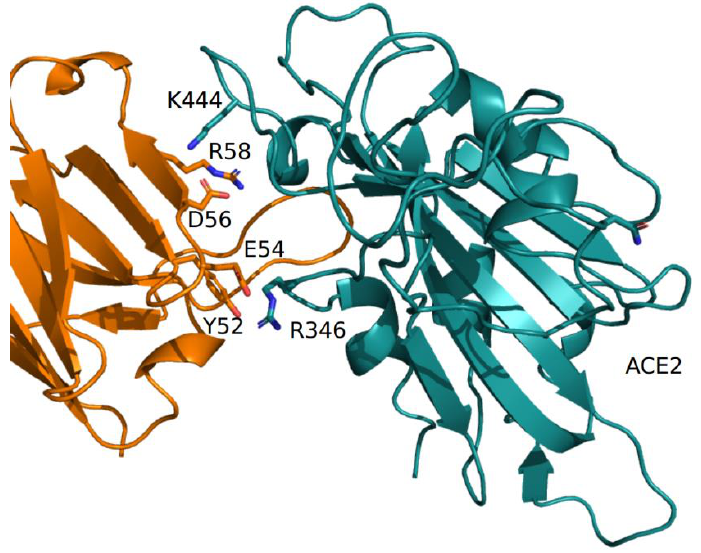
Figure 6. Complex between the COV38-142 antibody-heavy chain (orange) and RBD (deep teal), as reported in the PDB coordinate set 7LM8. Interacting side chains are displayed with stick models and are labeled. The label «ACE2» marks the interface to the receptor.